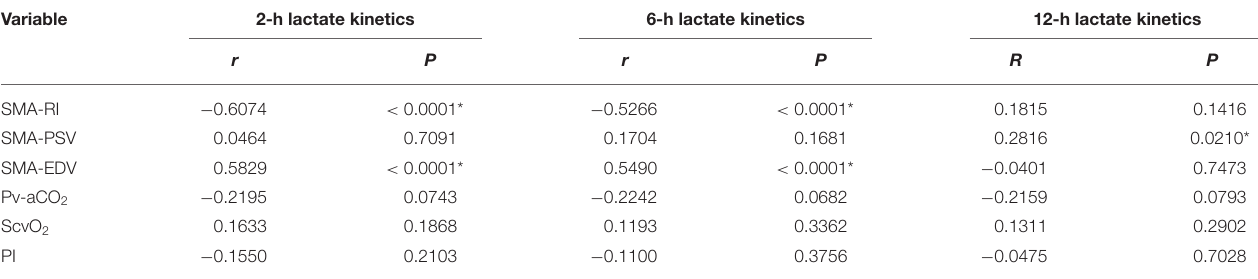
TABLE 3 | Correlation analysis of lactate kinetics, superior mesenteric artery flow, and hemodynamic parameters. Variable